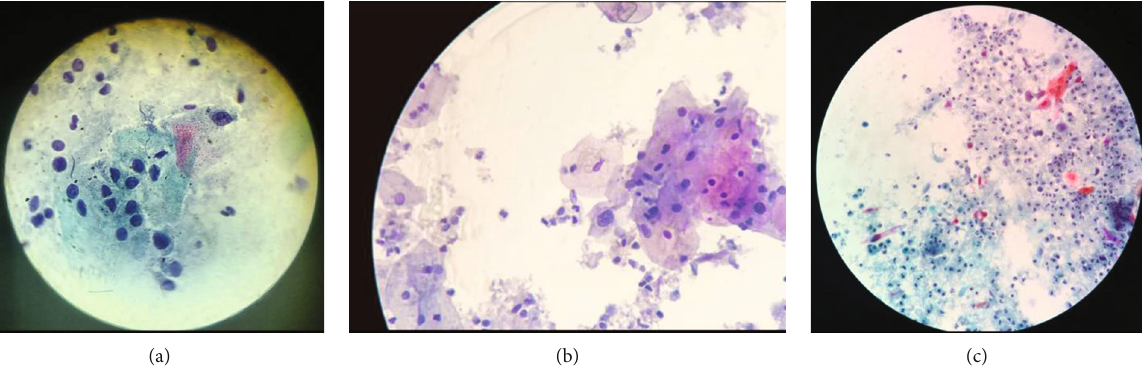
Figure 1: (a) NILM. (b) Precancerous lesions. (c) Cancerous lesions. ∗ NILM: negative for intraepithelial lesion/malignancy. Table 1: Age-wise parity distribution of HPV-positive patients ( n = 48 ).